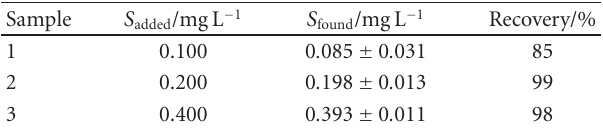
Table 3: Recovery results for synthetic samples of elemental sul- phur.